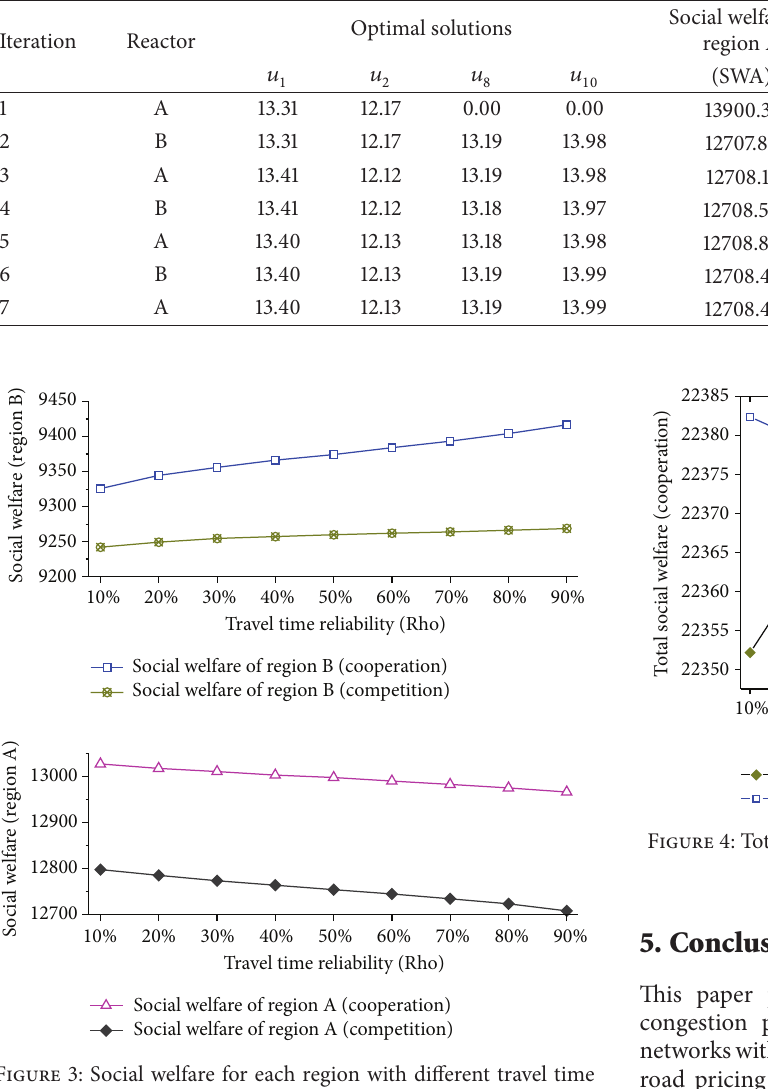
Figure 3: Social welfare for each region with different travel time reliability.